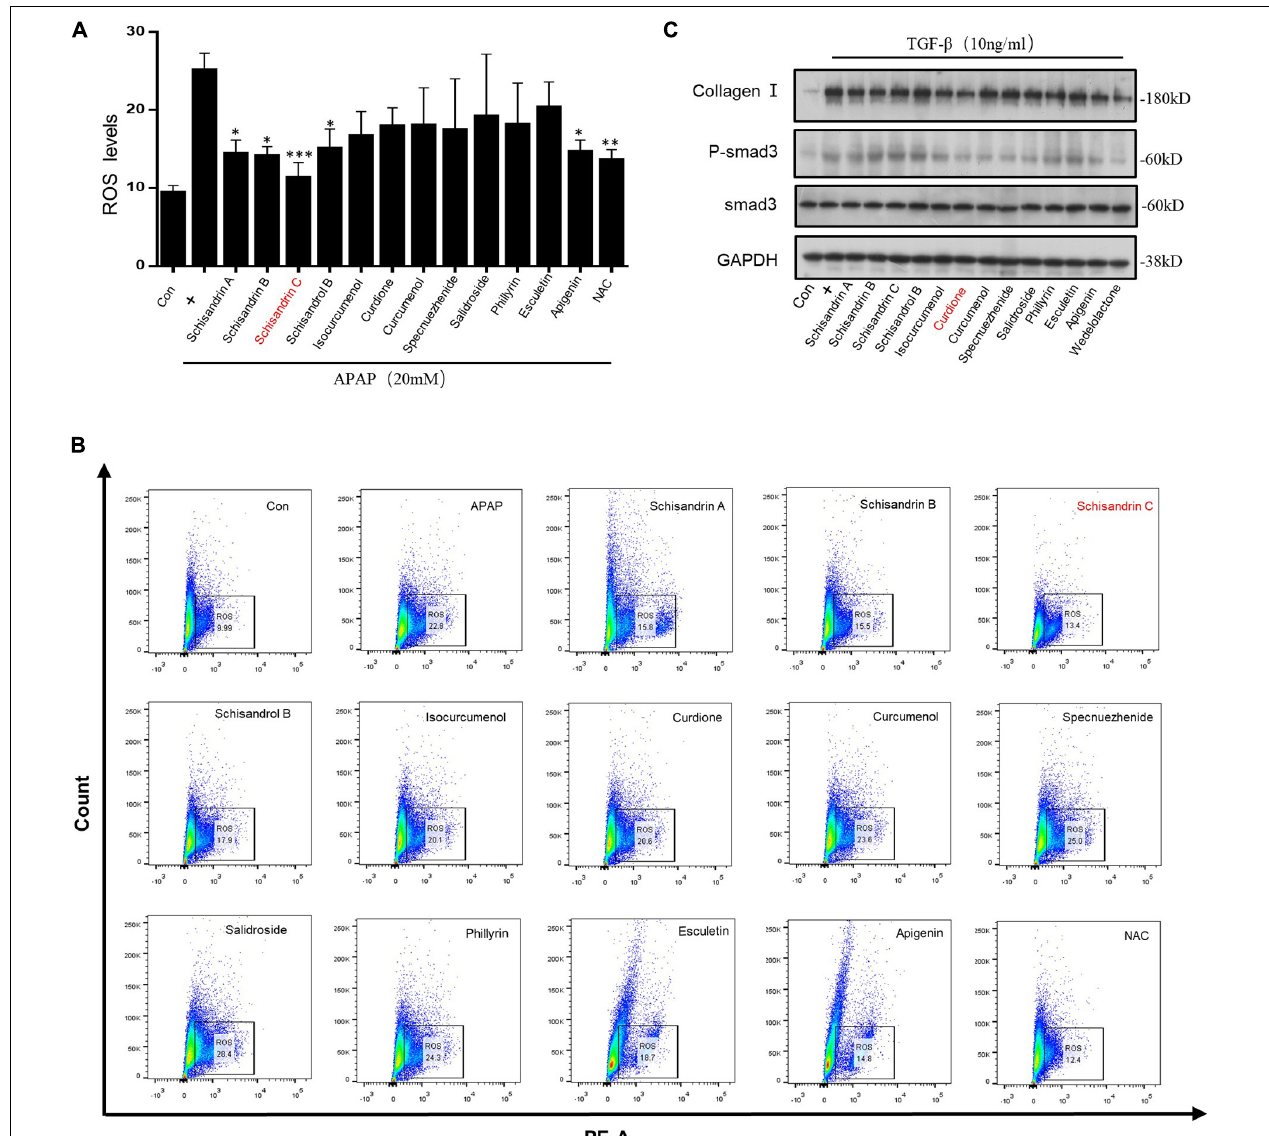
FIGURE 1 | Screening of active ingredients in vitro based on inhibiting oxidative stress and blocking TGF- β 1/Smad-mediated hepatic stellate cells (HSC) activation. (A,B) The percentage of ROS positive cells were detected with MitoSox staining and analyzed by FACS. (C) Western blot analysis of Collagen I, Smad3, p-Smad3, GAPDH in LX-2 cells treated with twelve active ingredients (40 µ M) in Liuwei Wuling tablets (LWWL) and then stimulated with TGF- β 1 (10 ng/ml). Data are expressed as the mean ± SD of three independent experiments in panels (A,B) , * p < 0.05, ** p < 0.01, and *** p <